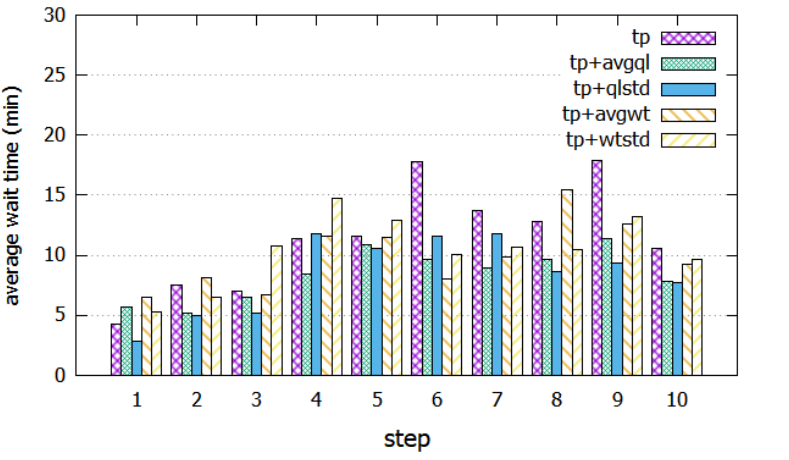
Figure 2. Performance of a technique for determining the phase order in terms of the average wait